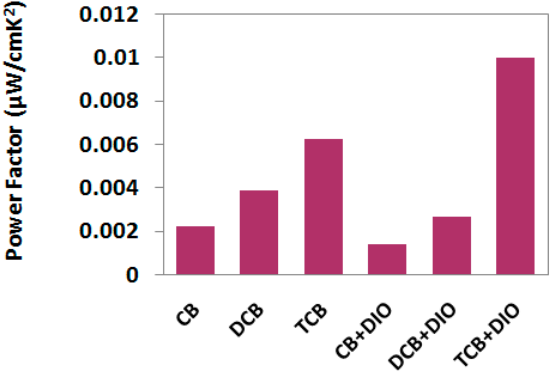
Figure 6. Power factor values of PTB7 samples prepared from different solvents with and without DIO.